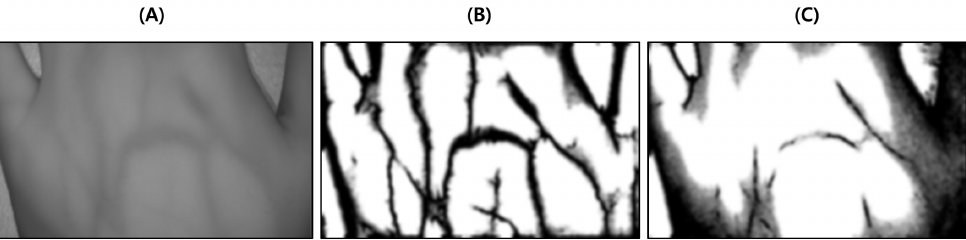
Figure 9. Comparison of image processing results with and without removing light: ( A ) is the original image, ( B ) has unbalanced lighting removed so the applied operations can usually work and strengthen the veins. ( C ) shows that the brightness of the unbalanced illumination is relatively darker than that of the vein, so the calculations are applied to the darkly illuminated area. This eliminates the contrast of